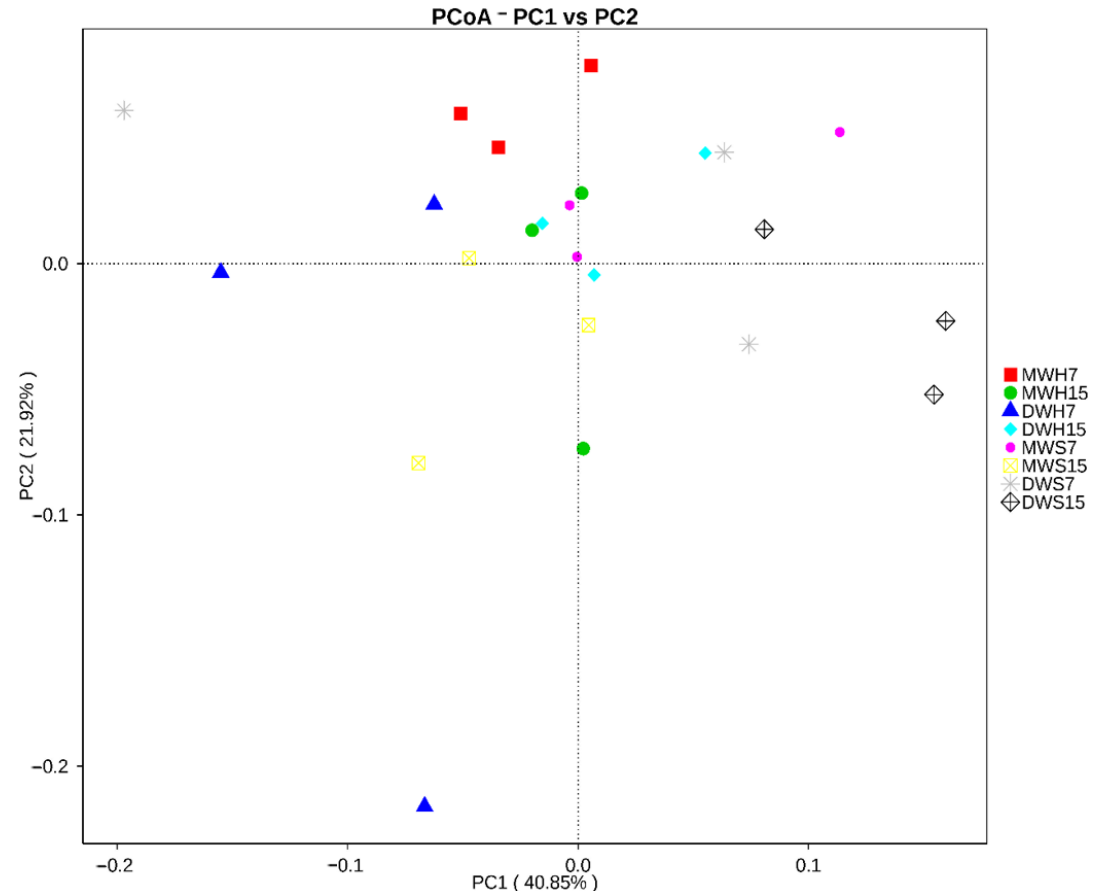
Figure 2. Principal coordinate analysis (PCoA) of microbial community structure in anaerobic digesters fed with different types of wheat, with shapes and colors representing different treatments. MWH7 = wheat harvested at 7:00 in milk stage and preserved as hay; MWS7 = wheat harvested at 7:00 in milk stage and preserved as silage; DWH7 = wheat harvested at 7:00 in dough stage and preserved as hay; DWS7 = wheat harvested at 7:00 in dough stage and preserved as silage; MWH15 = wheat harvested at 15:00 in milk stage and preserved as hay; MWS15 = wheat harvested at 15:00 in milk stage and preserved as silage; DWH15 = wheat harvested at 15:00 in dough stage and preserved as hay; DWS15 = wheat harvested at 15:00 in dough stage and preserved as